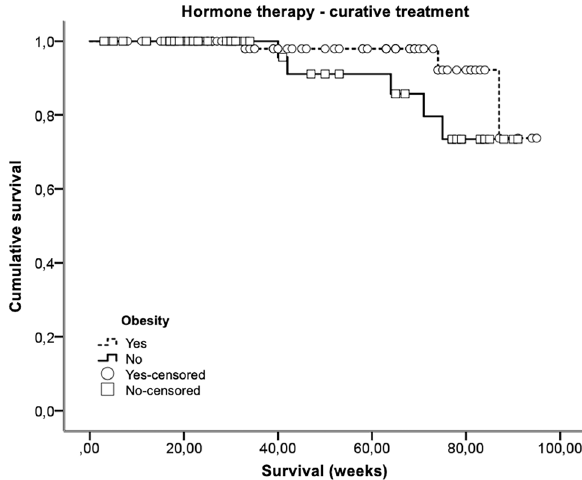
Image 8. Survival curve, in the Kaplan-Meier assessment, relating obesity to survival, among patients undergoing hormone therapy with curative treatment intent Non-obese: mean of 91.05 weeks; Obese: mean 82.90 weeks (Kaplan-Meier test - Log rank/Mantel-Cox: p=0.175) As between patients undergoing chemotherapy, both with curative and palliative treatment intent, there was no difference between non-obese and obese patients in terms of survival (Kaplan- Meier test – log-rank/Mantel-Cox - curative chemotherapy: p =0.806; palliative chemotherapy: p =0.610). These results are shown in Figures 10 and 11, respectively.